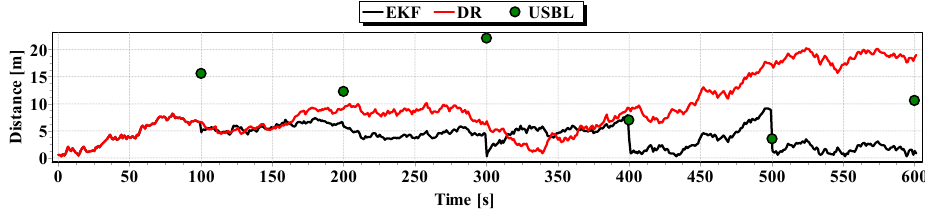
Figure 29. Graph of the reference position distance from the position estimated by EKF and DR